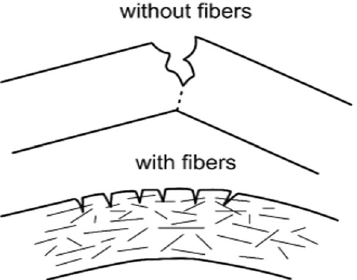
Fig. 3 Difference between vegetable-fiber-reinforced concrete and one without incorporated fibers [61,